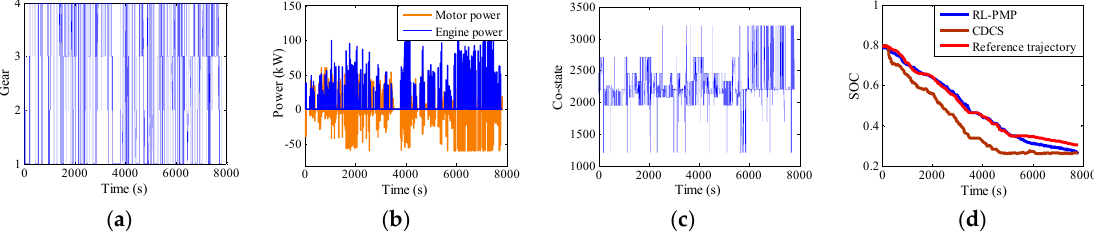
Figure 23. The HIL results of No.23. (a) denotes the gears, (b) denotes the powers of the motor and the engine, (c) denotes the co-state, and (d) denotes the SOC trajectories.